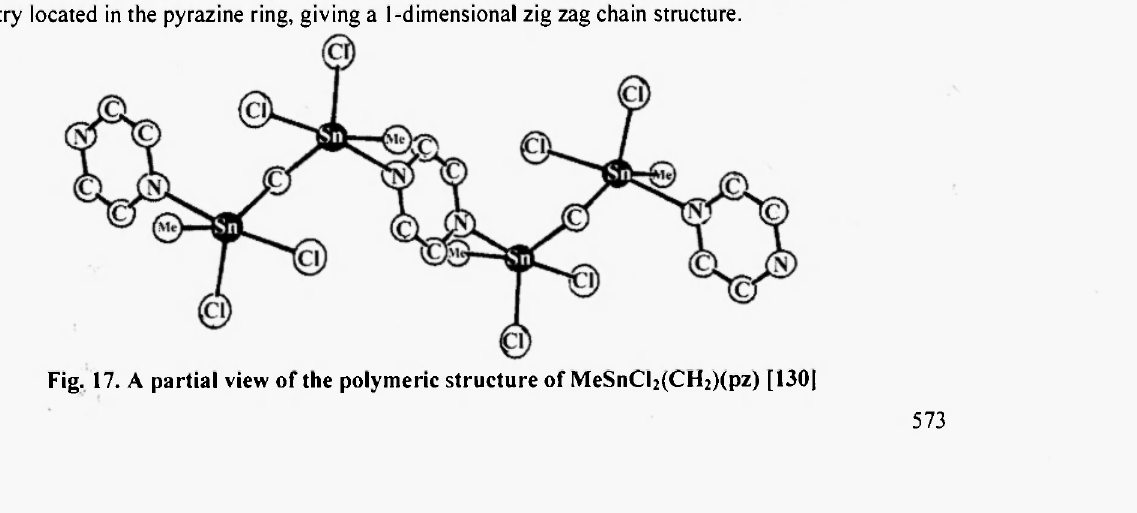
Fig. 17. A partial view of the polymeric structure of MeSnCl 2 (CH 2 )(pz)